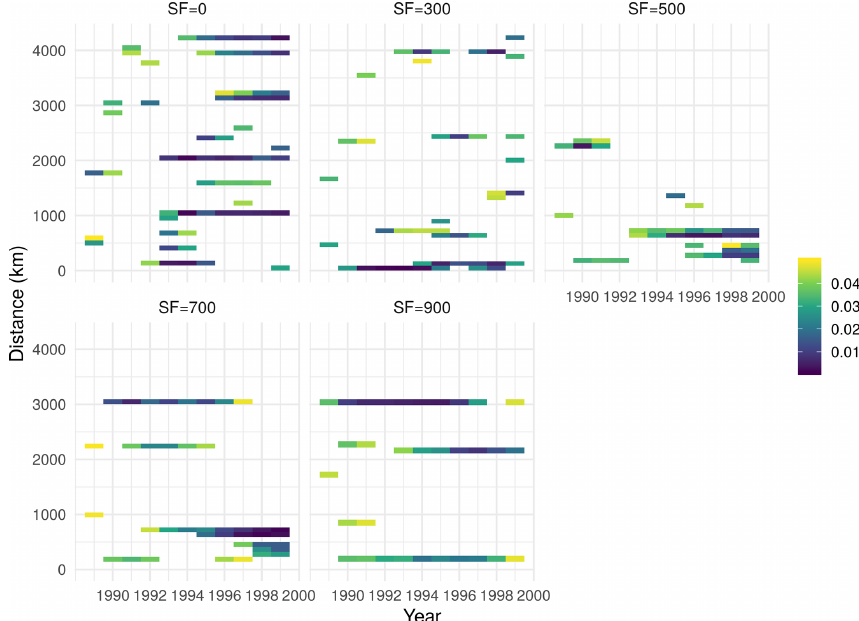
Figure B1. Significant spatial autocorrelation ( p value < 0 . 05) found for different values of scaling factors ( ν ) in Eq. (9) across a range of distances and years